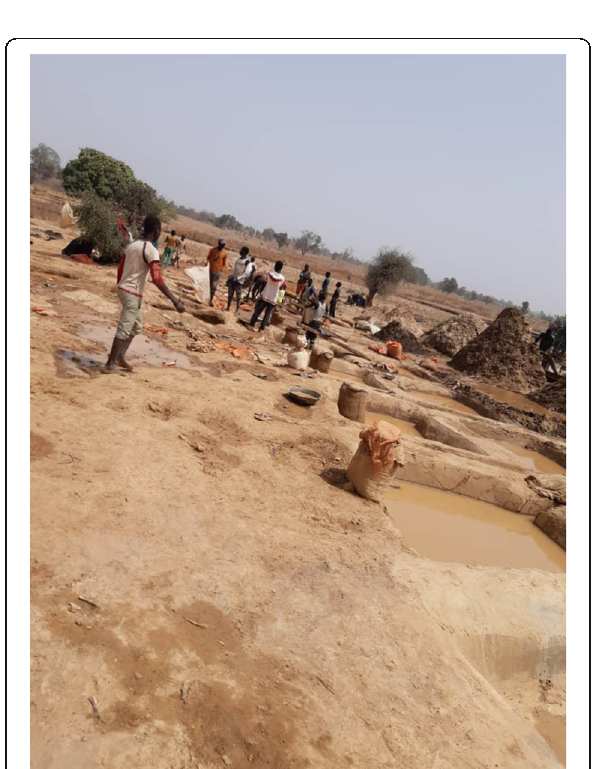
Fig. 5 Site 4 of the local mining